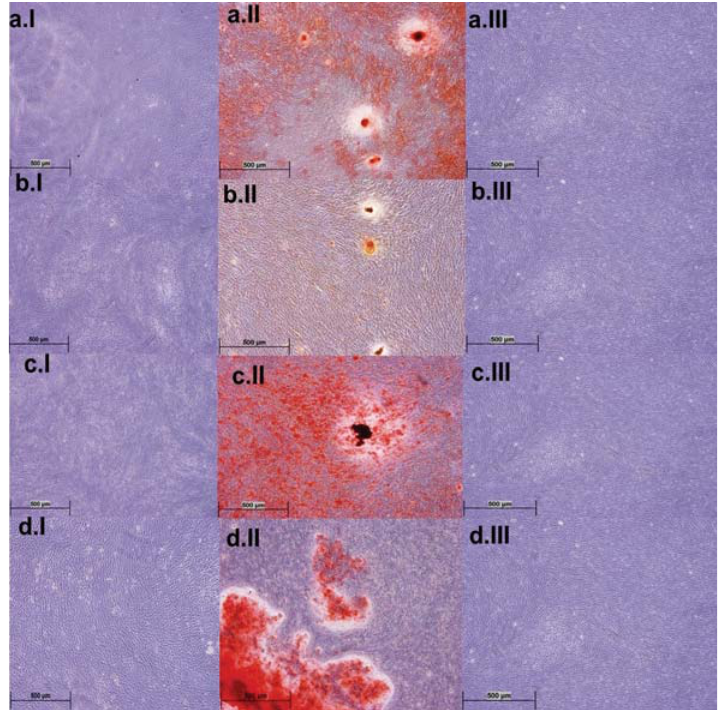
Figure 4- (cid:3)(cid:51)(cid:82)(cid:87)(cid:72)(cid:81)(cid:87)(cid:76)(cid:68)(cid:79)(cid:3)(cid:71)(cid:76)(cid:73)(cid:73)(cid:72)(cid:85)(cid:72)(cid:81)(cid:87)(cid:76)(cid:68)(cid:87)(cid:76)(cid:82)(cid:81)(cid:3)(cid:82)(cid:73)(cid:3)(cid:71)(cid:72)(cid:81)(cid:87)(cid:68)(cid:79)(cid:3)(cid:83)(cid:88)(cid:79)(cid:83)(cid:3)(cid:86)(cid:87)(cid:72)(cid:80)(cid:3)(cid:70)(cid:72)(cid:79)(cid:79)(cid:86)(cid:3)(cid:11)(cid:39)(cid:51)(cid:54)(cid:38)(cid:86)(cid:12)(cid:3)(cid:85)(cid:72)(cid:73)(cid:72)(cid:85)(cid:85)(cid:72)(cid:71)(cid:3)(cid:68)(cid:86)(cid:3)(cid:38)(cid:82)(cid:81)(cid:87)(cid:85)(cid:82)(cid:79)(cid:3)(cid:42)(cid:85)(cid:82)(cid:88)(cid:83)(cid:3)(cid:11)(cid:68)(cid:17)(cid:44)(cid:16)(cid:44)(cid:44)(cid:44)(cid:12)(cid:30)(cid:3)(cid:68)(cid:71)(cid:76)(cid:83)(cid:82)(cid:74)(cid:72)(cid:81)(cid:76)(cid:70)(cid:3)(cid:71)(cid:76)(cid:73)(cid:73)(cid:72)(cid:85)(cid:72)(cid:81)(cid:87)(cid:76)(cid:68)(cid:87)(cid:76)(cid:82)(cid:81)(cid:3)(cid:90)(cid:68)(cid:86)(cid:3)(cid:81)(cid:82)(cid:87)(cid:3) shown in DPSCs Control Group (a.I) and in the Extract Group (b-d.I). Osteogenic differentiation was observed in Control Group (a.II) with calcium granules and extracellular matrix. Calcium granules are seen as black nodules and the extracellular matrix was dyed red. The extract of S. aromaticum (b.II) reduced the dying of extracellular matrix and formation of calcium granules. C. zeylanicum (c.II) induced calcium granules and extracellular matrix formation, while S. triloba (d.II) showed reduced effect. The cells with SC medium are shown in a-d.III (4x, Olympus CKX41,Tokyo,